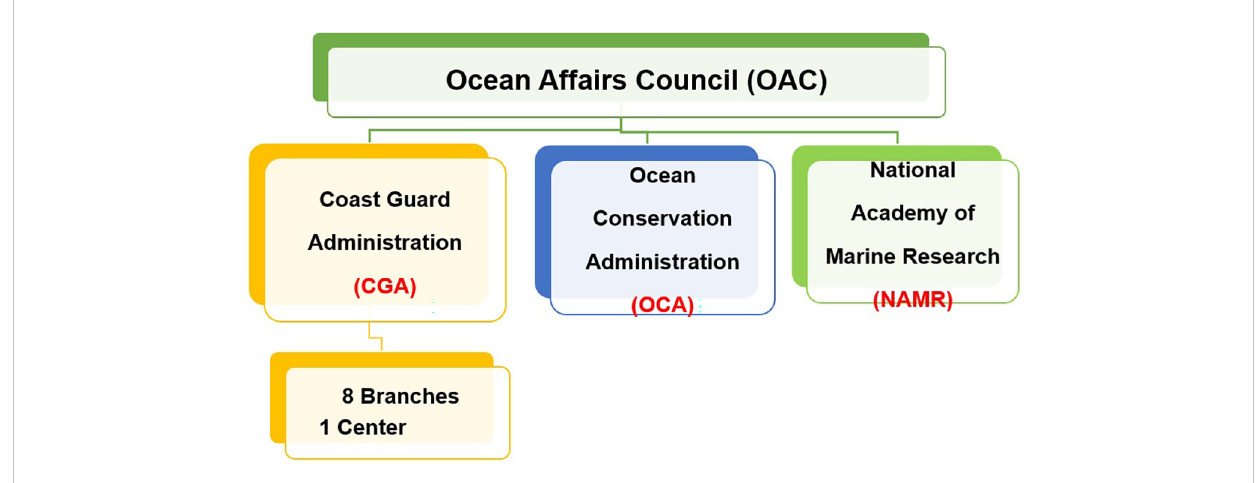
FIGURE 1 An organization chart of OAC.